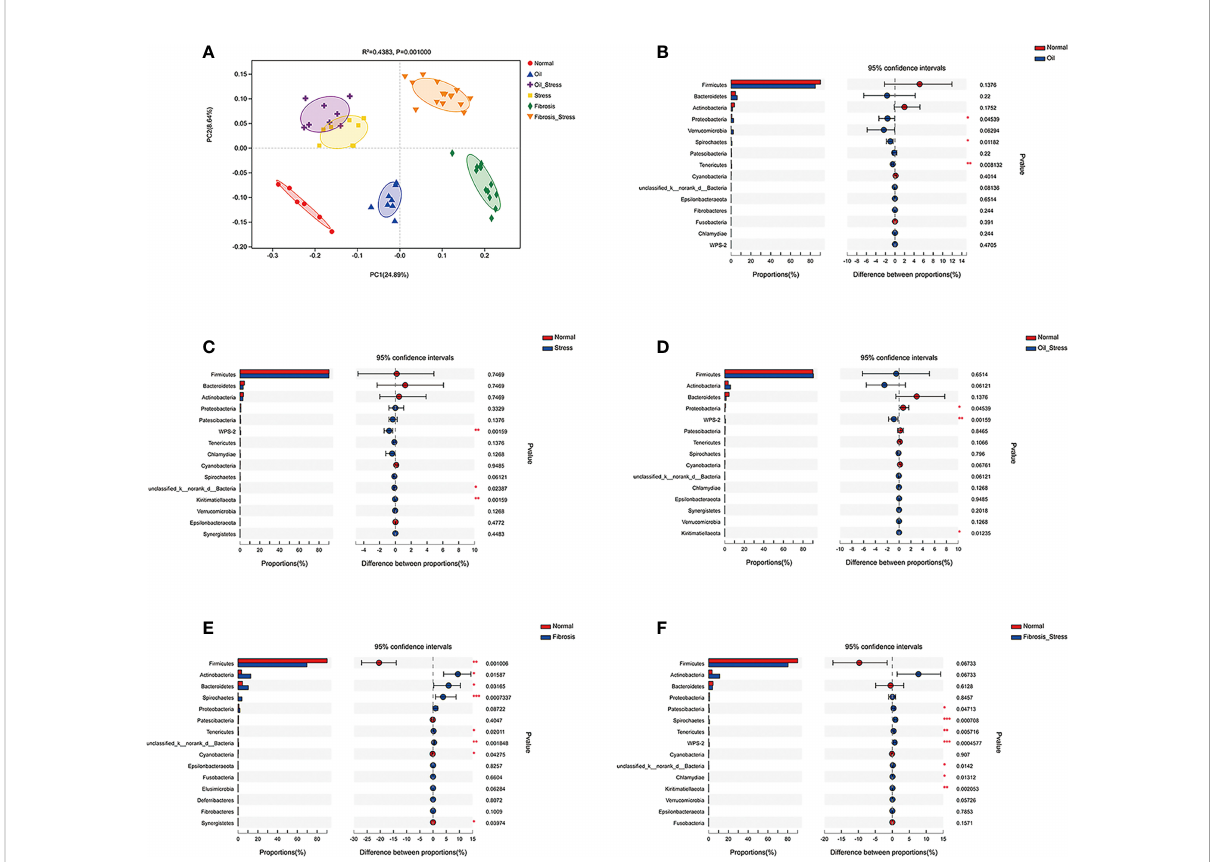
FIGURE 2 Diversity of gut microbiota in rats. (A) PCoA analysis of Beta diversity of gut microbiota. (B-F) Difference analysis of the abundance of gut microbiota at the phylum level vs. the normal group. (B) Proteobacteria was increased in the oil group ( p < 0.05). (C) WPS-2 bacteria was increased in the stress group ( p < 0.01). (D) Proteobacteria ( p < 0.05) and WPS-2 bacteria ( p <0.01) were increased in the oil+stress group. (E) Firmicutes ( p < 0.01), Actinobacteria ( p <0.05), Spirochaete ( p < 0.01), Tenericutes ( p < 0.05) and Bacteroidetes ( p < 0.05) were increased in the fi brosis group. (F) WPS-2 bacteria ( p < 0.01), Firmicutes ( p > 0.05), Actinobacteria ( p > 0.05), Spirochaete ( p < 0.01), Tenericutes ( p < 0.01), Patescibacteria ( p < 0.05) and WPS-2 bacteria ( p < 0.001) were increased in the fi brosis+stress group. Data are shown as means ± SD. * p < 0.05; ** p <0.01; *** p < 0.001 vs. normal